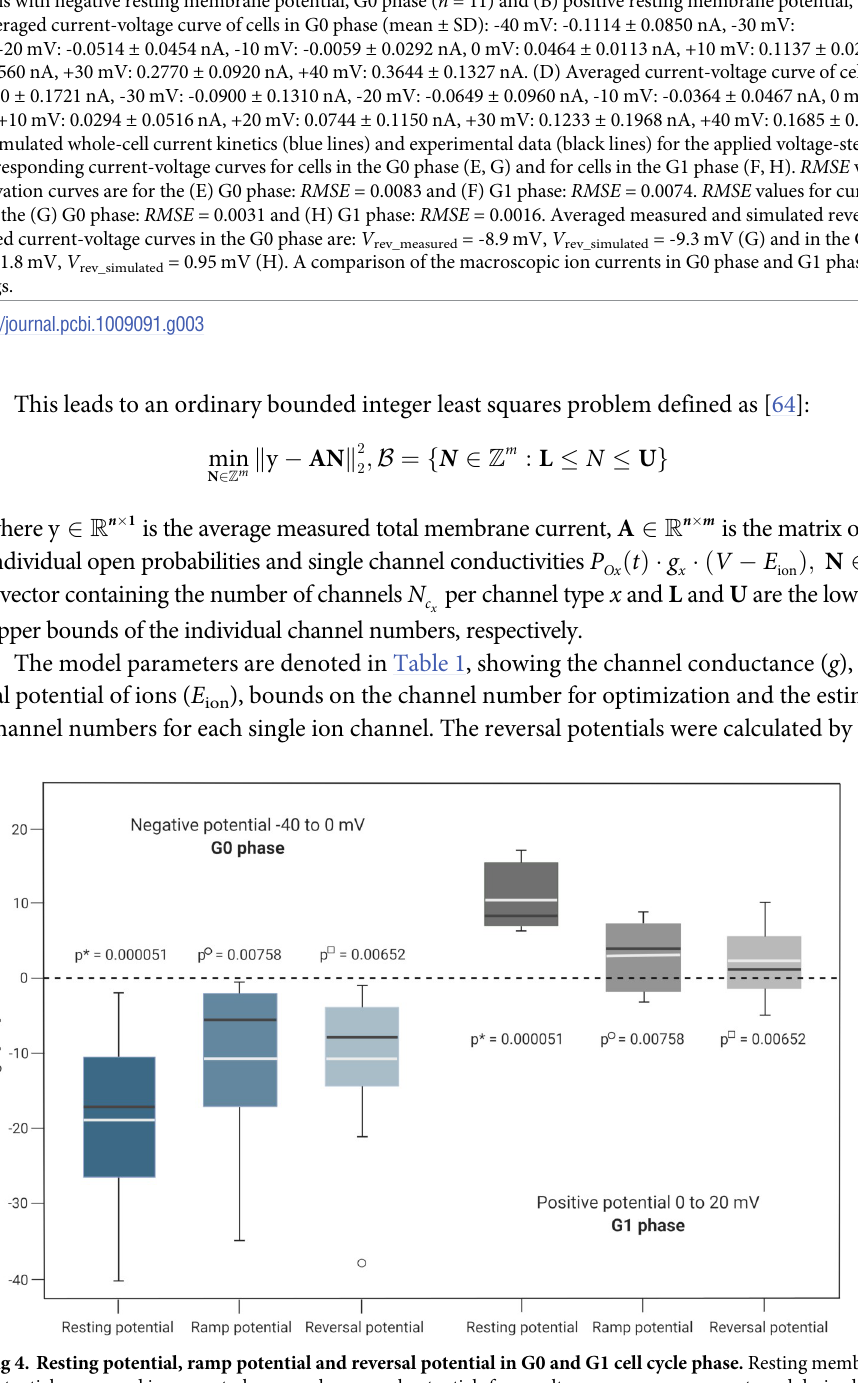
Fig 3. Measured and simulated whole-cell current response. Averaged whole-cell current curves measured at voltage-steps from -40mV to +40mV for (A) cells with negative resting membrane potential, G0 phase ( n = 11) and (B) positive resting membrane potential, G1 phase ( n = 5). (C) Averaged current-voltage curve of cells in G0 phase (mean ± SD): -40mV: -0.1114 ± 0.0850 nA, -30mV: -0.0849 ± 0.0671 nA, -20mV: -0.0514 ± 0.0454nA, -10mV: -0.0059 ± 0.0292 nA, 0 mV: 0.0464 ± 0.0113nA, +10 mV: 0.1137 ± 0.0286nA, +20 mV: 0.1903 ± 0.0560nA, +30 mV: 0.2770 ± 0.0920nA, +40 mV: 0.3644 ± 0.1327nA. (D) Averaged current-voltage curve of cells in G1 phase: -40mV: -0.1140 ± 0.1721nA, -30mV: -0.0900 ± 0.1310nA, -20 mV: -0.0649 ± 0.0960nA, -10 mV: -0.0364 ± 0.0467nA, 0mV: -0.0065 ± 0.0088nA, +10mV: 0.0294 ± 0.0516nA, +20mV: 0.0744 ± 0.1150nA, +30 mV: 0.1233 ± 0.1968nA, +40 mV: 0.1685 ± 0.2794 nA. Comparison of simulated whole-cell current kinetics (blue lines) and experimental data (black lines) for the applied voltage-step protocol, and the corresponding current-voltage curves for cells in the G0 phase (E, G) and for cells in the G1 phase (F, H). RMSE values for simulation of activation curves are for the (E) G0 phase: RMSE = 0.0083 and (F) G1 phase: RMSE = 0.0074. RMSE values for current- voltage curves are for the (G) G0 phase: RMSE = 0.0031 and (H) G1 phase: RMSE = 0.0016. Averaged measured and simulated reversal potentials from derived current-voltage curves in the G0 phase are: V rev_measured = -8.9 mV, V rev_simulated = -9.3 mV (G) and in the G1 phase: V rev_measured = 1.8mV, V rev_simulated = 0.95mV (H). A comparison of the macroscopic ion currents in G0 phase and G1 phase can be found in S3–S7 Figs.